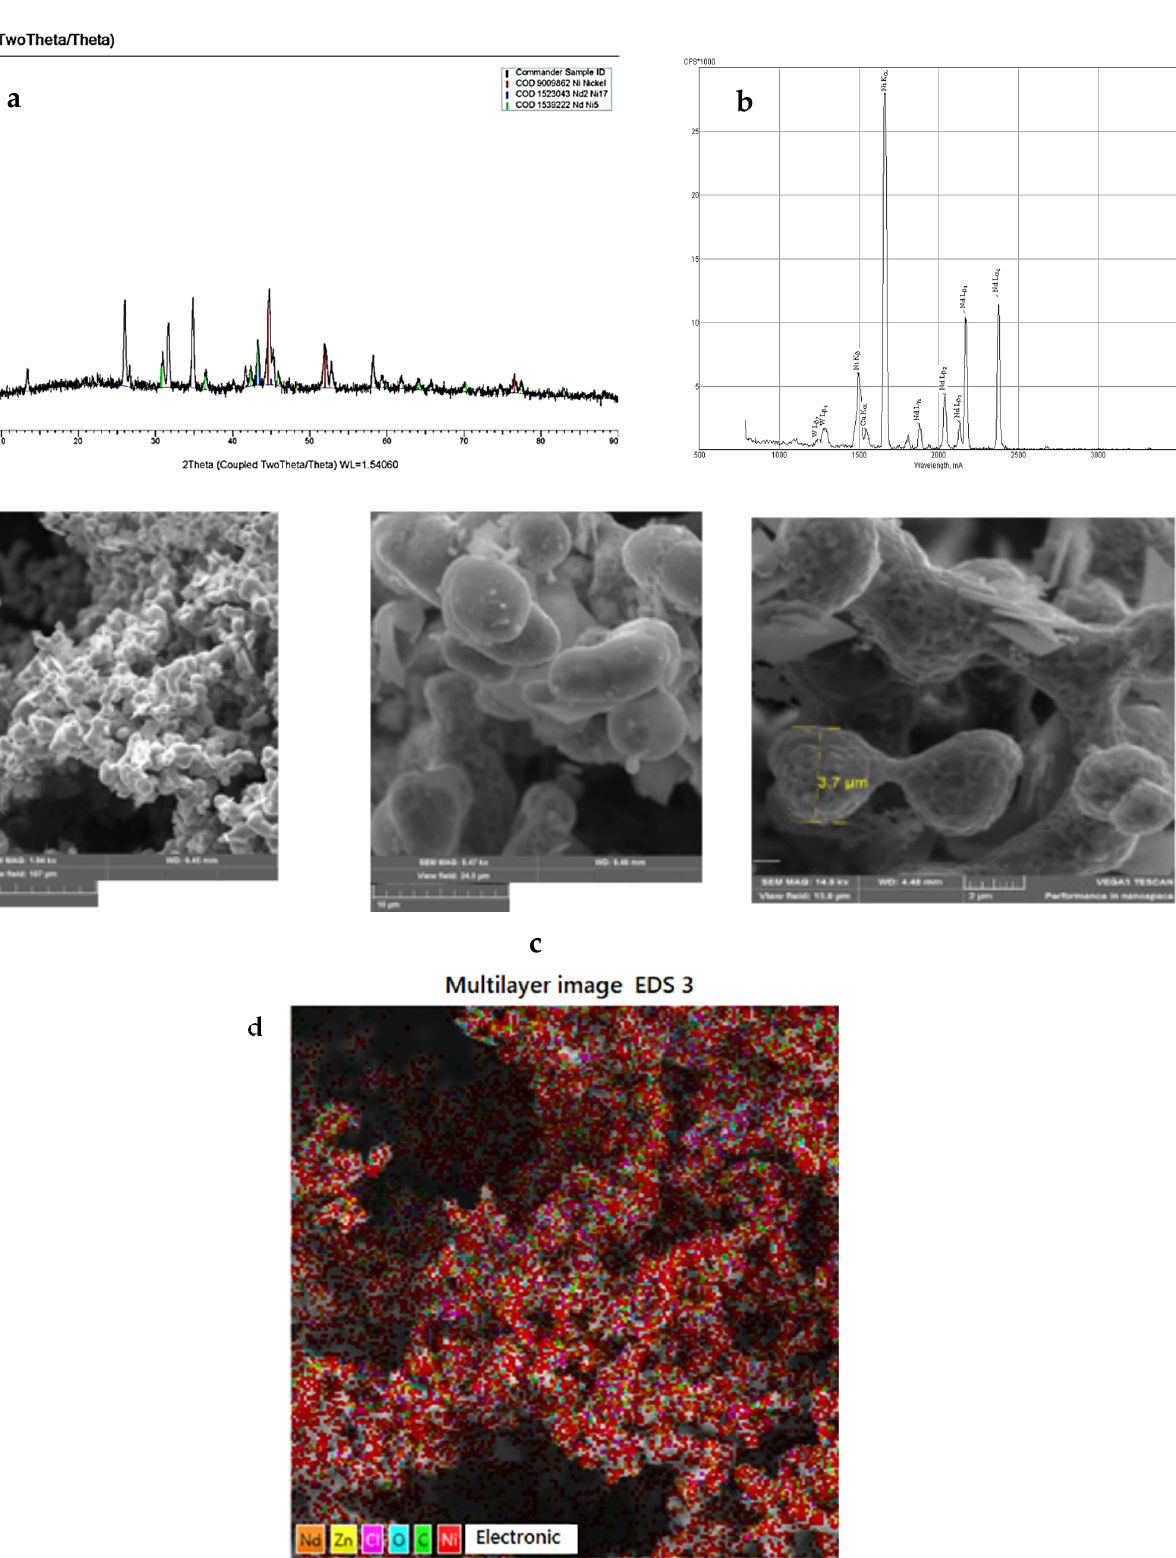
Figure 6. X-ray diffraction pattern ( a ), elemental analysis ( b ), SEM images of the synthesized samples surfaces ( c ), and color map of the elemental distribution ( d ) of the cathode deposit obtained by the potentiostatic electrolysis of the KCl-NaCl-NdCl 3 -NiCl 2 melt at the voltage of 3.2 V, electrolysis potential of − 1.5 V vs. Ag/AgCl, and at 973 К for 5 h. Concentration of NdCl 3 is 3.0 × 10 − 4 mol/cm 3 . Concentration of NiCl 2 is 0.5 × 10 − 4 mol/cm 3 .